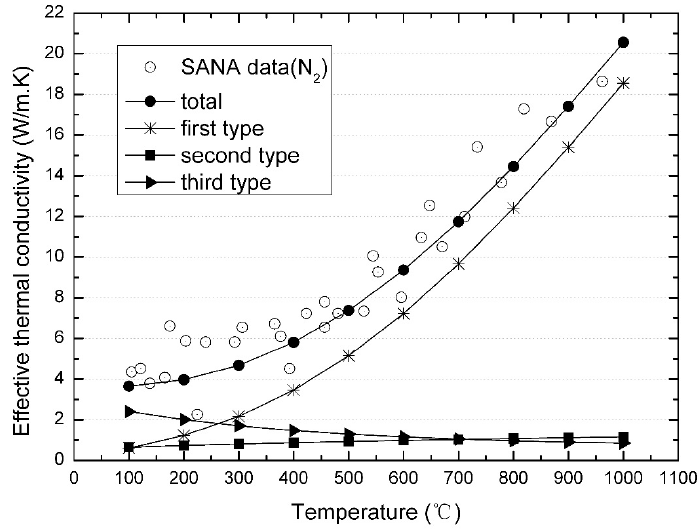
Figure 7. Total effective thermal conductivity and the experimental data of the pebble bed in SANA experiment under nitrogen conditions.